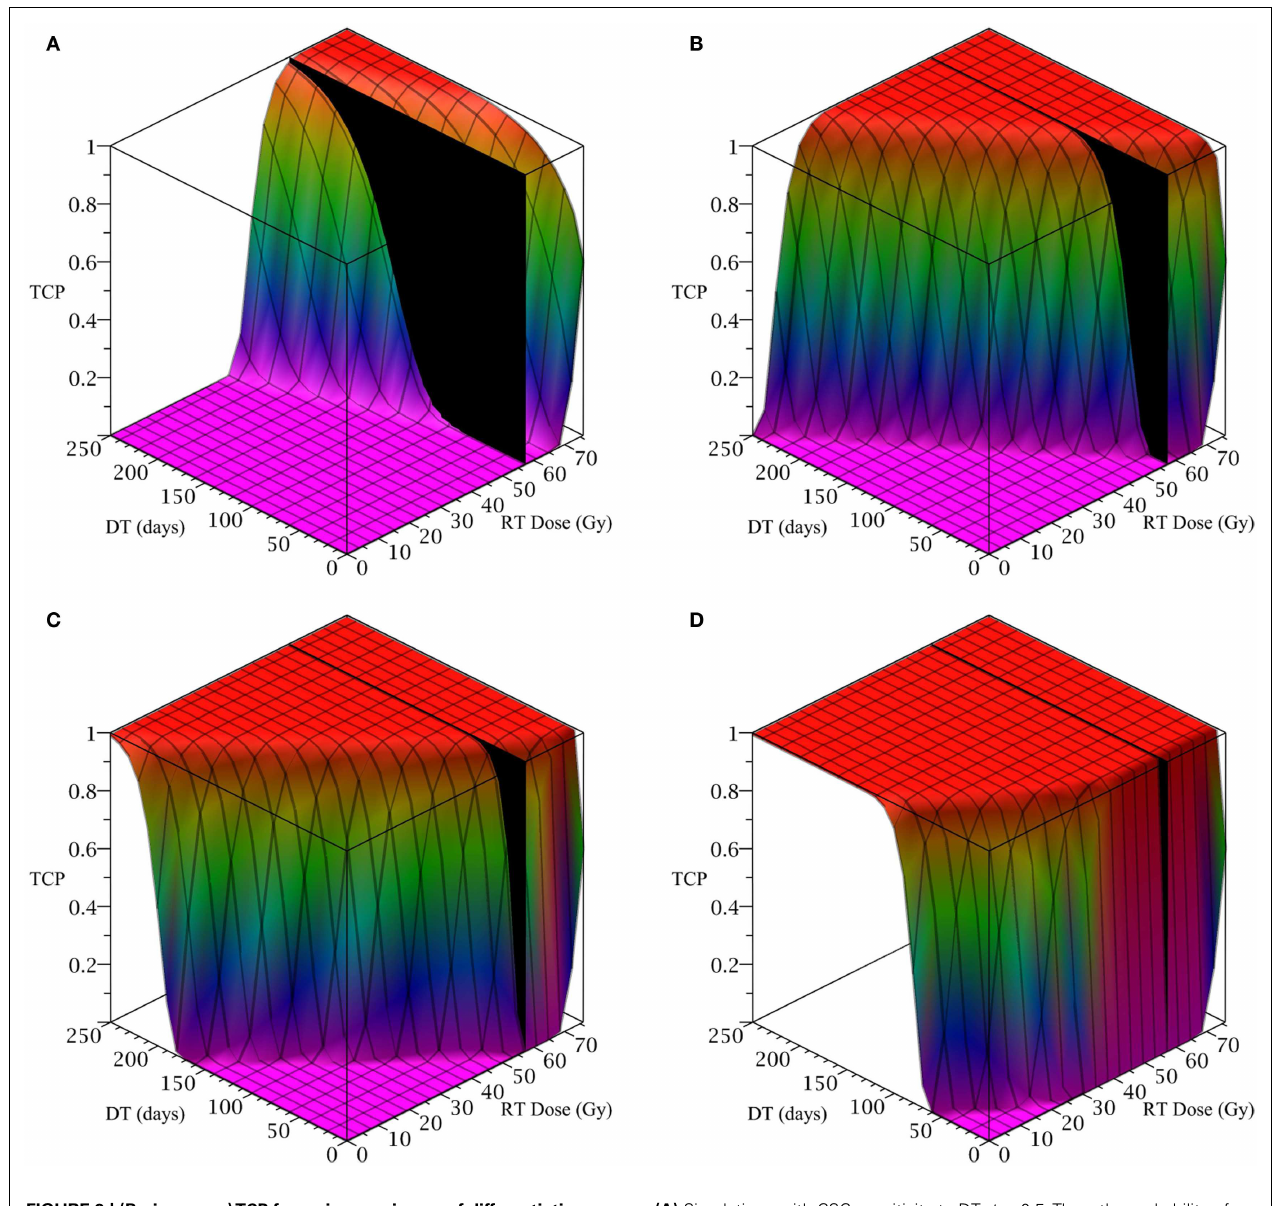
FIGURE 3 | (Brain cancer)TCP for various regimens of differentiation therapy (DT), radiation therapy (RT), and combination therapy, as applied to a simulated brain cancer with average parameter values. The RT protocol and tumor parameters are described in Table 1 .